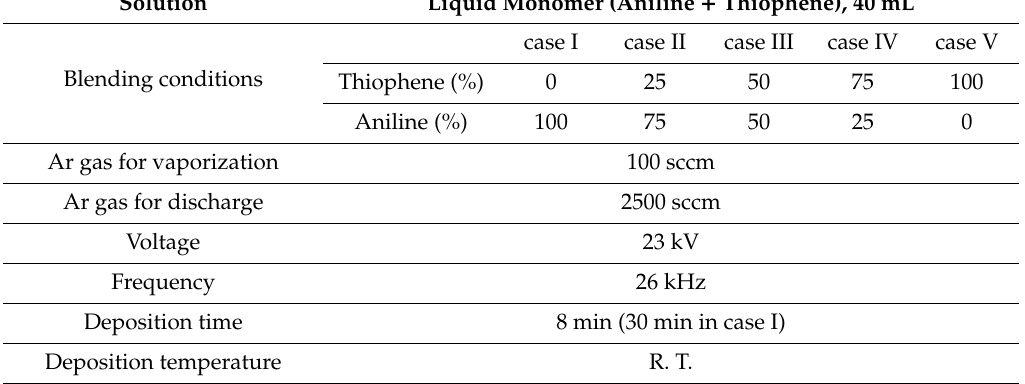
Table 1. Blending ratios of aniline and thiophene monomers and deposition conditions of APPJs polymerization